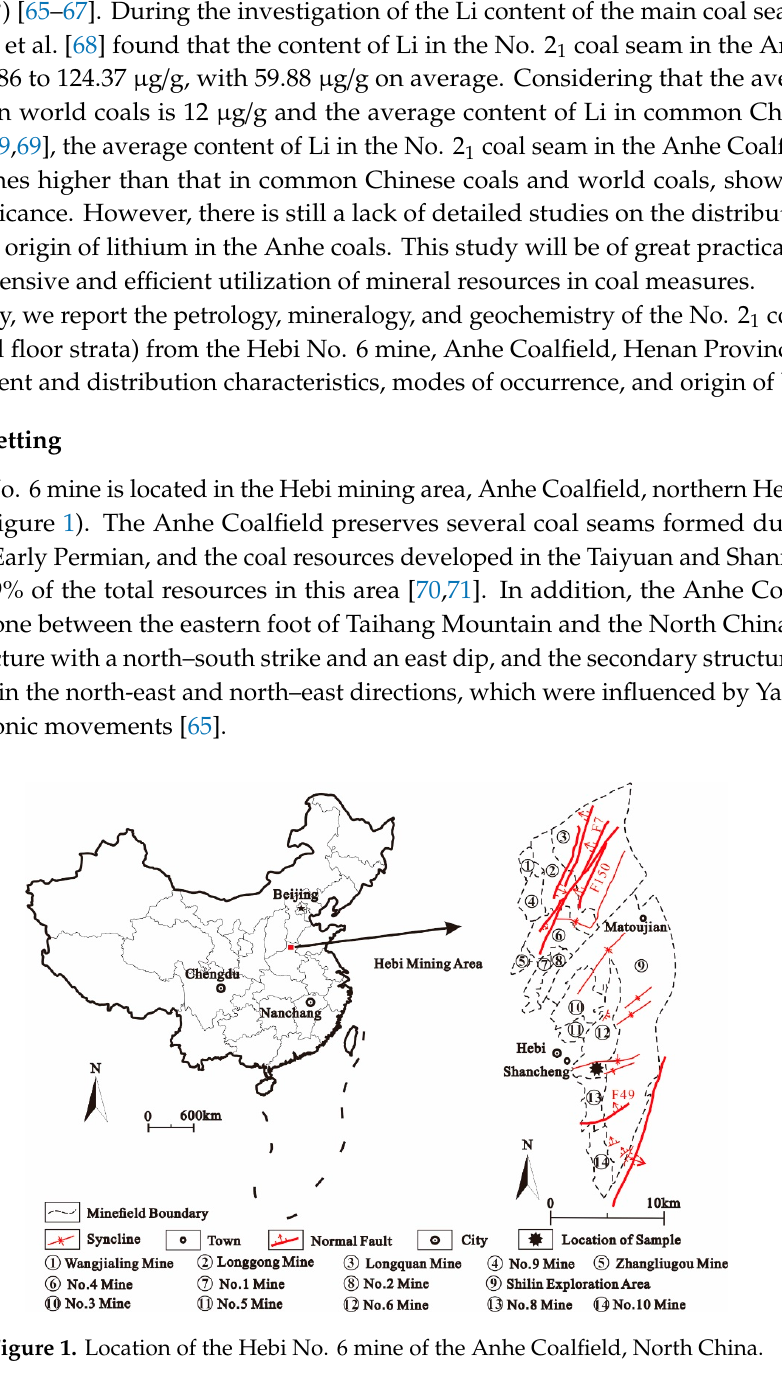
Figure 2. ( A ) Sedimentary sequences [71] and ( B ) the vertical sampled section of the No. 2 1 coal from the Hebi No. 6 mine, Anhe Coalfield. The red pentagram represents the coal seam studied in this paper.